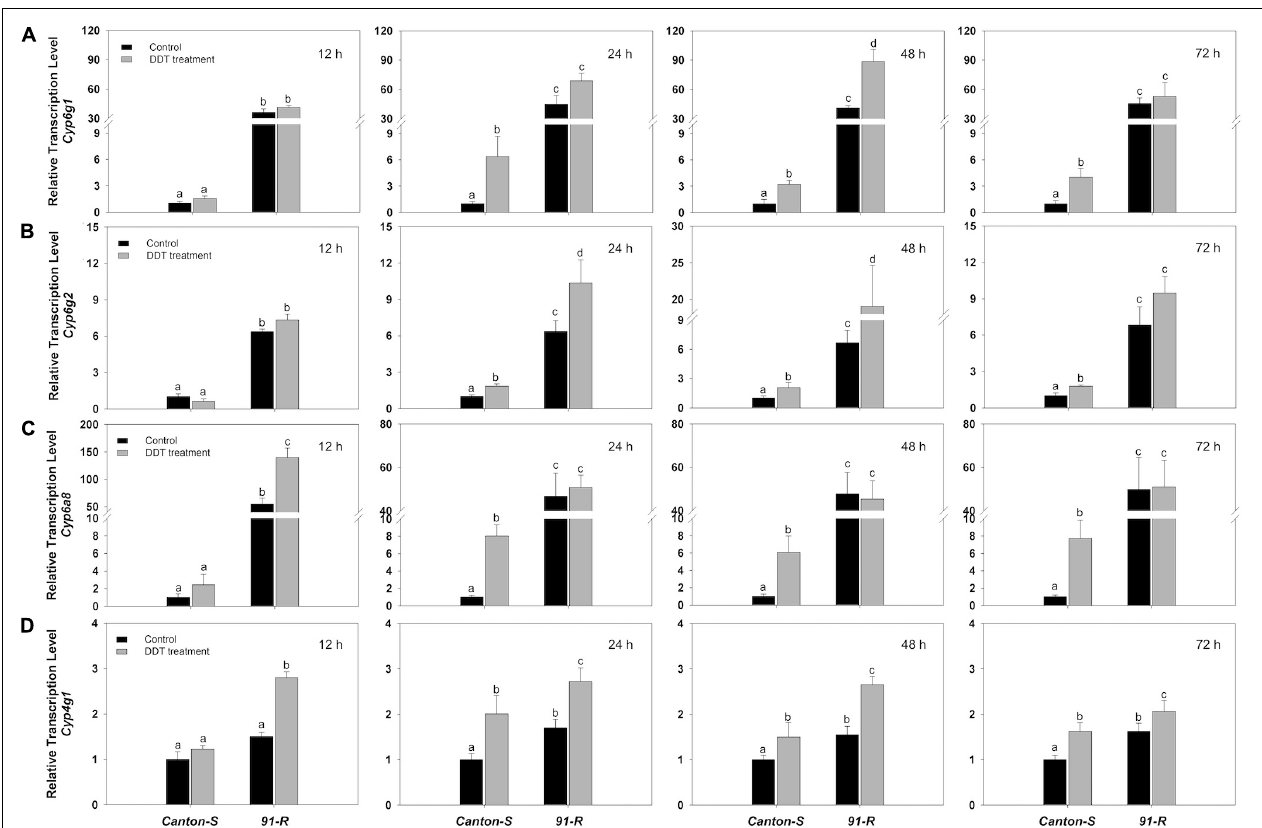
FIGURE 3 | The expression of target P450s (A) Cyp6g1 , (B) Cyp6g2 , (C) Cyp6a8 , and (D) Cyp4g1 in DDT-resistant 91-R and the DDT-susceptible Canton-S strains following DDT exposure. The induction or repression level of expression were analyzed 12, 24, 48, and 72 h after DDT exposure. The relative levels of gene expression shown along the Y axis represent the ratio of the gene expression in each treatment compared to the acetone-treated Canton-S strain. The experiments were repeated three times. The vertical bars indicate SEM. Different letters on the bars indicate that the means are significantly different throughout the strains where the P -value <